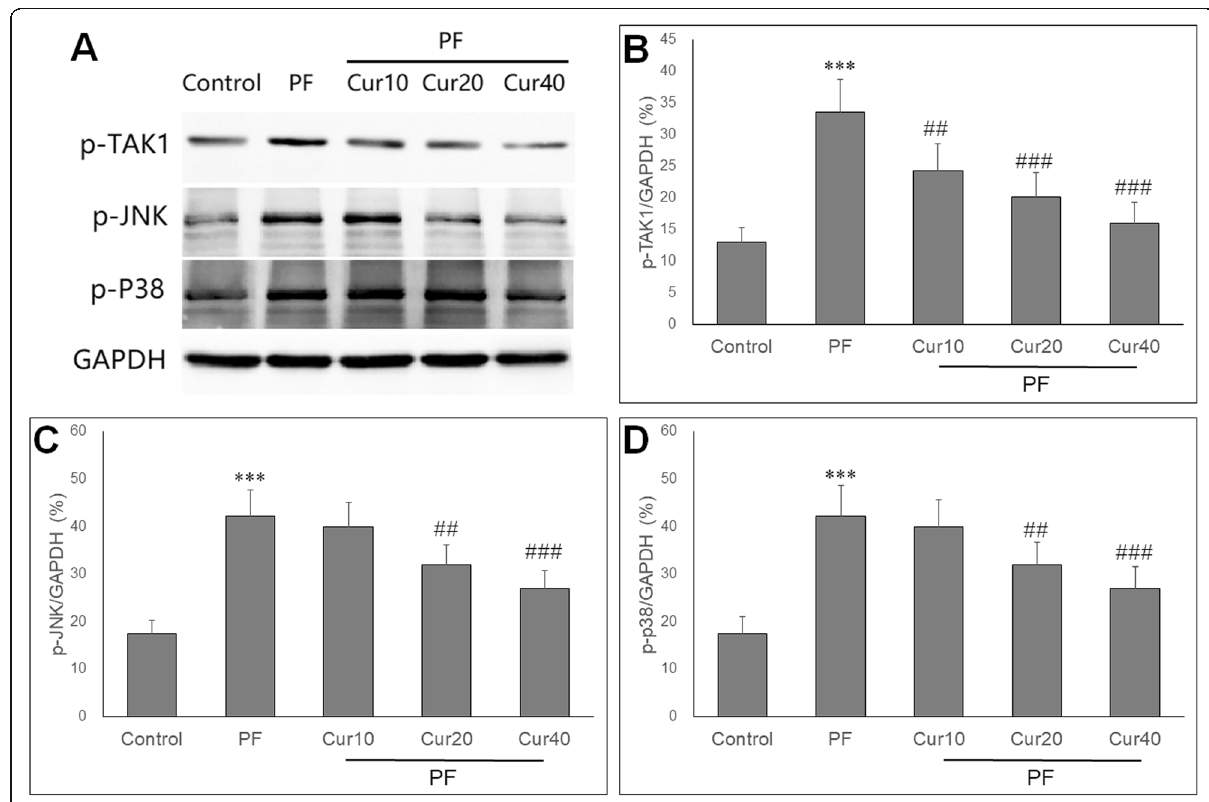
Fig. 7 Effect of curcumin on protein expressions of TAK1, JNK and p38 in PF rats. a Representative immunoblots of p-TAK1, p-JNK, p-p38 and GAPDH in PF rats of each group were shown. After induction of PF, the protein levels of p-TAK1 ( b ), p-JNK ( c ) and p-p38 ( d ) were significantly increased. Curcumin markedly reduced protein levels of p-TAK1, p-JNK and p-p38 at moderate (20 mg/kg) and high (40 mg/kg) doses in PF rats. ANOVA was performed and followed with Tukey ’ s post hoc test. *** P < 0.001 vs. control group; ## P < 0.01, ### P < 0.001 vs. PF